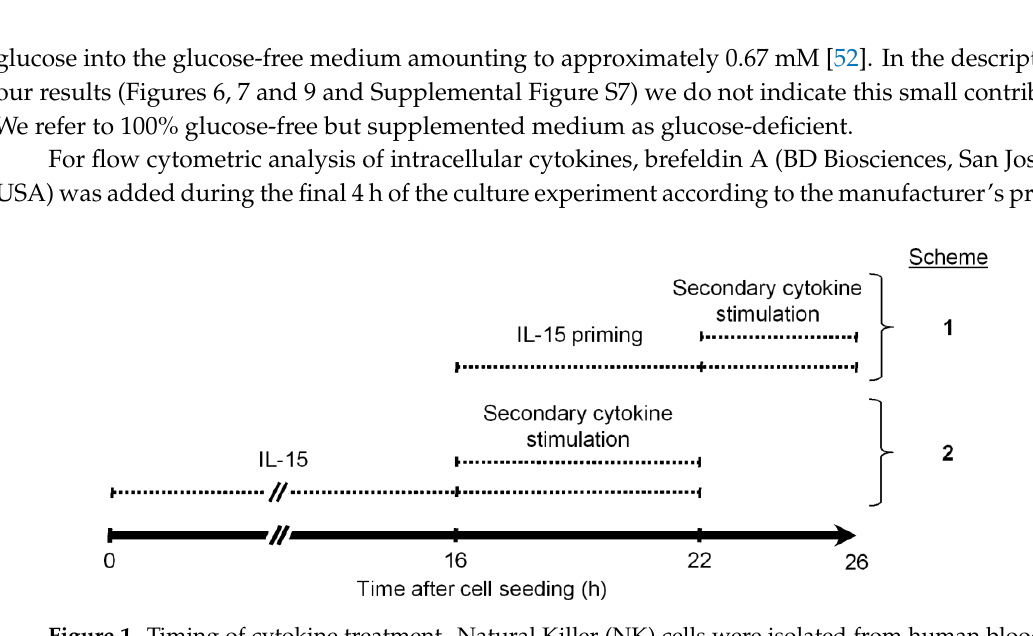
Figure 1. Timing of cytokine treatment. Natural Killer (NK) cells were isolated from human blood, seeded and cytokine treated according to two schemes. Scheme 1 was applied in all experiments and was compared to scheme 2 , exclusively, in an analysis of IFN γ production (Figure 2). Parallel culture manipulations at 16 and 22 h in both schemes simplified the experimental workflow.